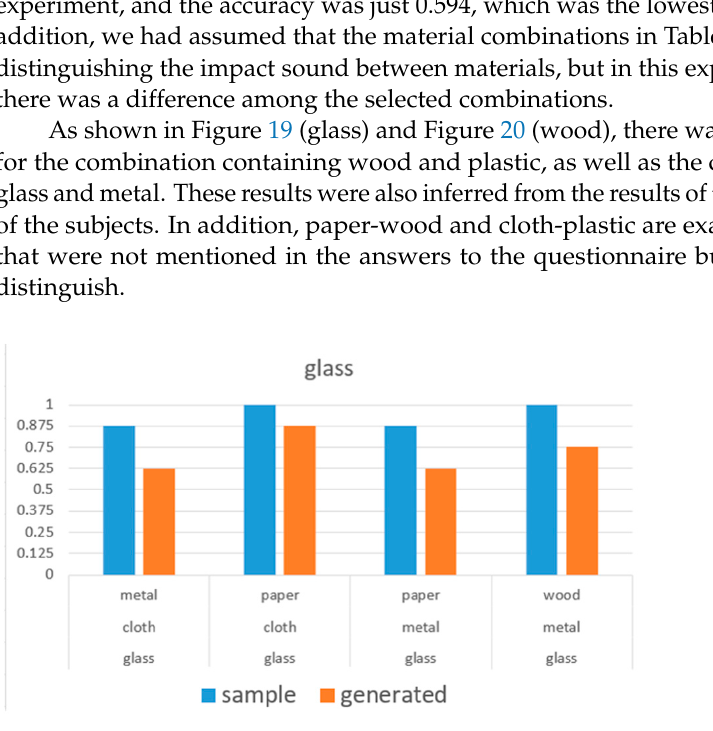
Figure 19. Accuracy of “glass” class in main (generated) and preliminary (sample) experiments.